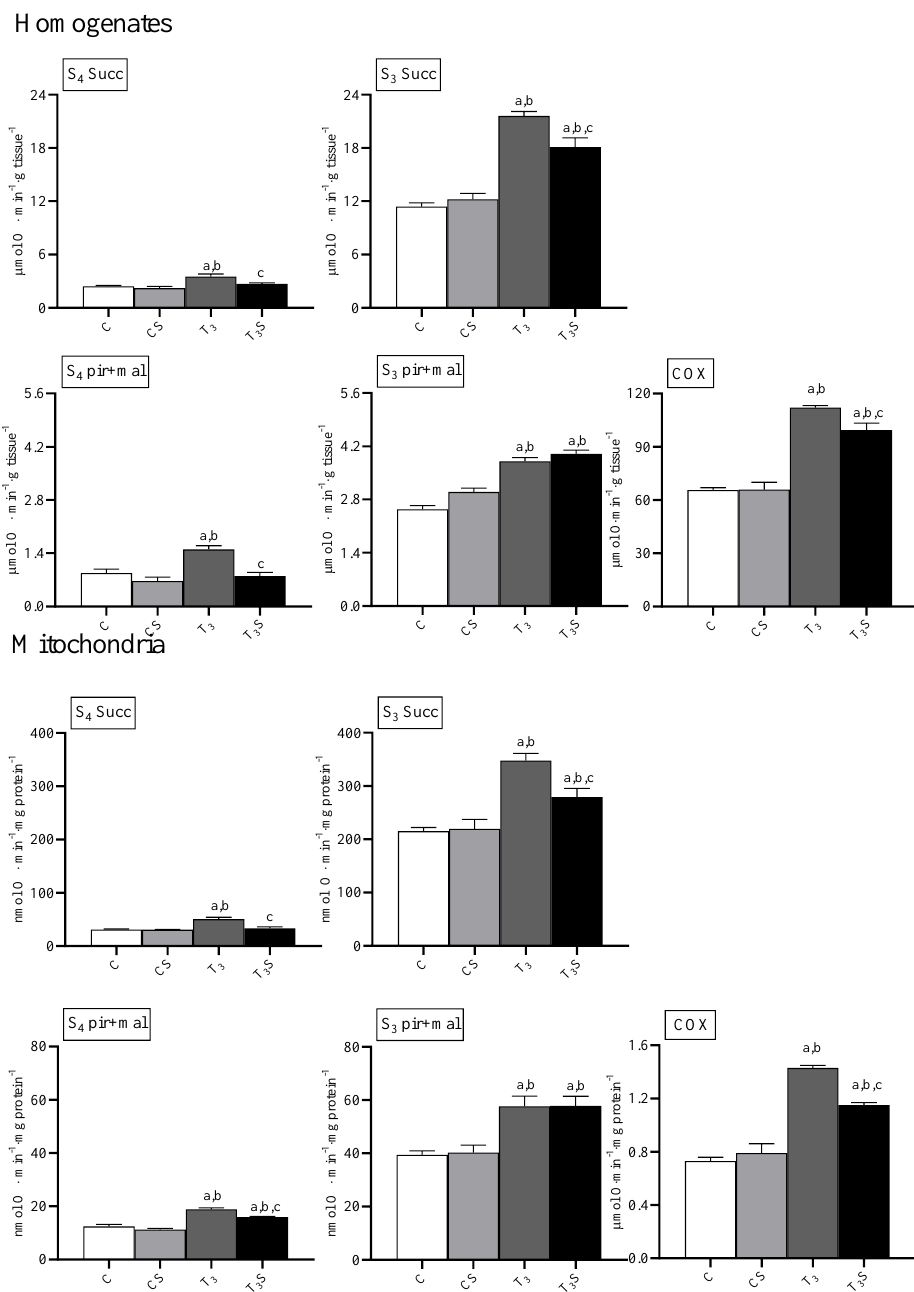
Figure 2. Rates of O 2 consumption and cytochrome oxidase (COX) activity in rat liver homogenates and mitochondria from: C, control rats; CS, control rats fed with Chlorella sorokiniana ; T 3 , rats made hyperthyroid by ip. T 3 administration; and T 3 S, hyperthyroid rats fed with Chlorella sorokiniana . Rates of O 2 consumption were measured in the absence (State 4, S 4 ) and in the presence (State 3, S 3 ) of ADP with Complex II (succinate, succ) and Complex I (pyruvate plus malate, pyr + mal)-linked substrates. The values are means ± S.E.M of the data obtained from eight di ff erent livers. a significant vs. C, b significant vs. CS, and c significant vs. T 3 . The level of significance was chosen as p < 0.05. In mitochondria, RCRs with succinate were 7.2 ± 0.09, 7.1 ± 0.14, 6.4 ± 0.09, and 7.7 ± 0.16 in C,